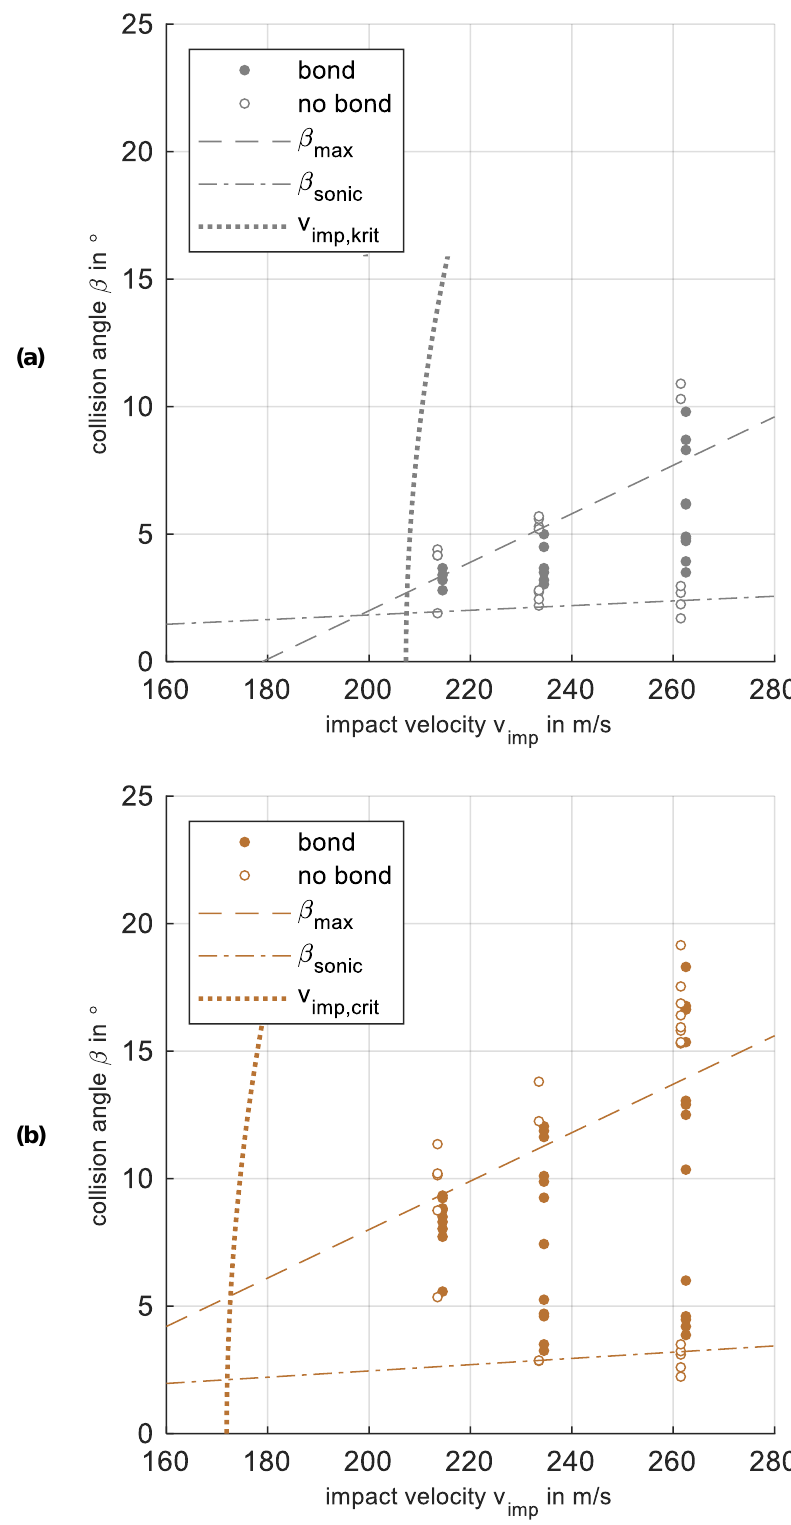
Figure 2. The resulting welding windows for similar combinations of Al–Al ( a ) and Cu–Cu ( b ). To im- prove the visibility of the data points, welded experiments are plotted with +0.5ms − 1 , non-welded with − 0.5ms − 1 . v imp,krit is the minimal impact velocity calculated by Equation (2). The subsonic boundary angle β sonic represents the surpassing of the speed of sound in the material by the collision point velocity. The upper collision angle boundary β max was obtained from the previous welding window investigation